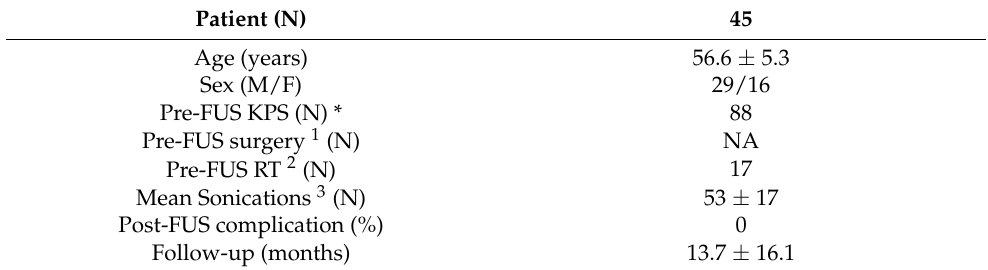
Table 4. Demographic and pre- and post-FUS session summary data of FUS-BBB Opening